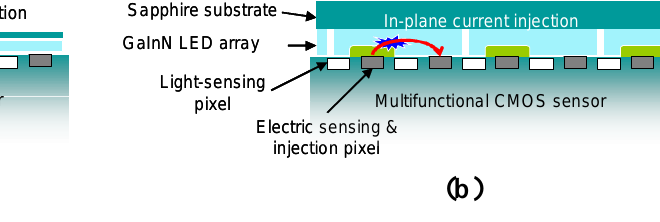
Figure 15. Current paths in the integrated light source with (a) an organic electroluminescence (EL) layer and (b) a GaInN LED